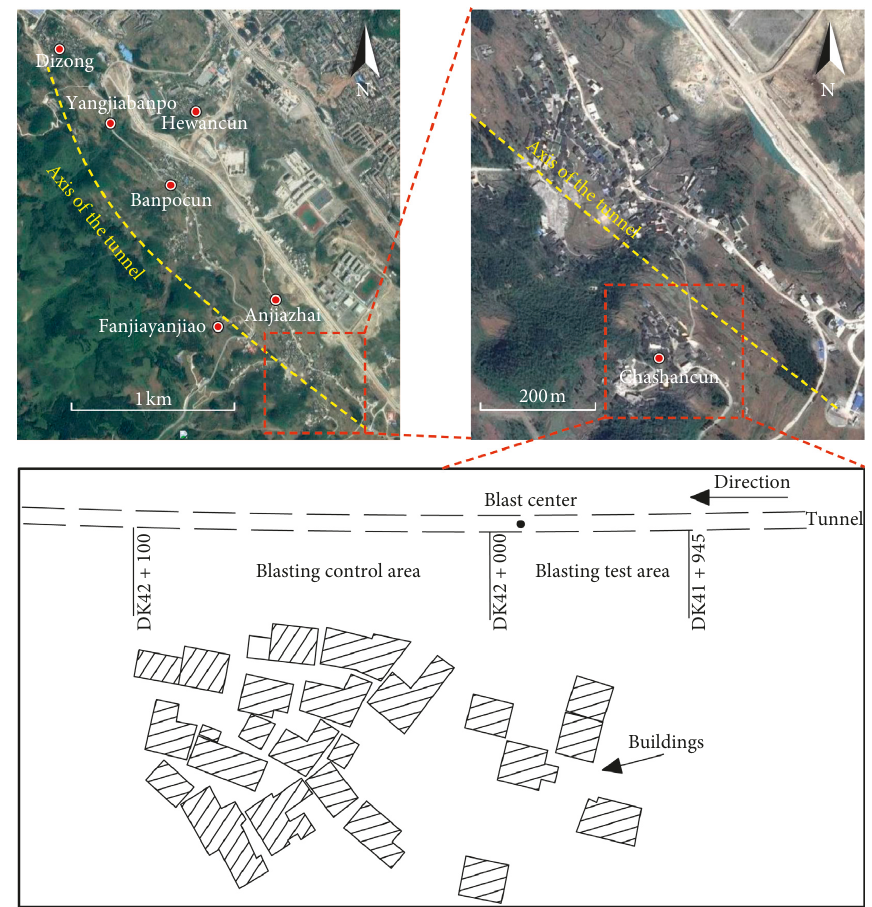
Figure 2: Diagram of the relationship between buildings and